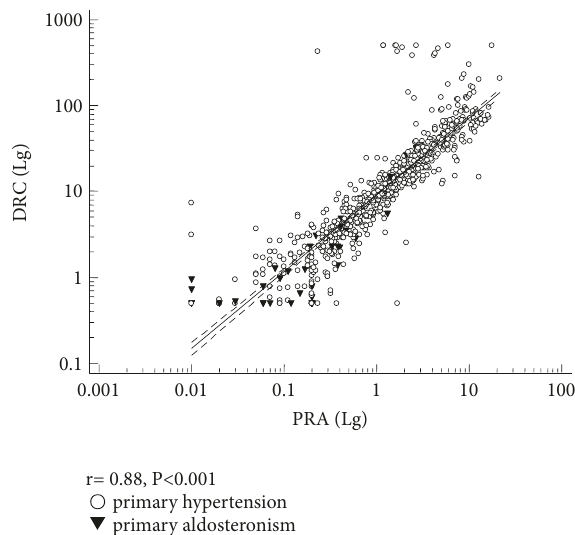
Figure 3: Regression curve of 𝑃𝐴𝐶 𝑅𝐼𝐴 and 𝑃𝐴𝐶 𝐶𝐿𝐼𝐴 . Dashed lines: confidence interval; continuous line: regression curve. R 2 =0.6439, Y=0.4431+0.7562 × X. PAC RIA : plasma aldosterone concentration measured by radioimmunoassay; PAC CLIA : plasma aldosterone con- centration measured by chemiluminescent